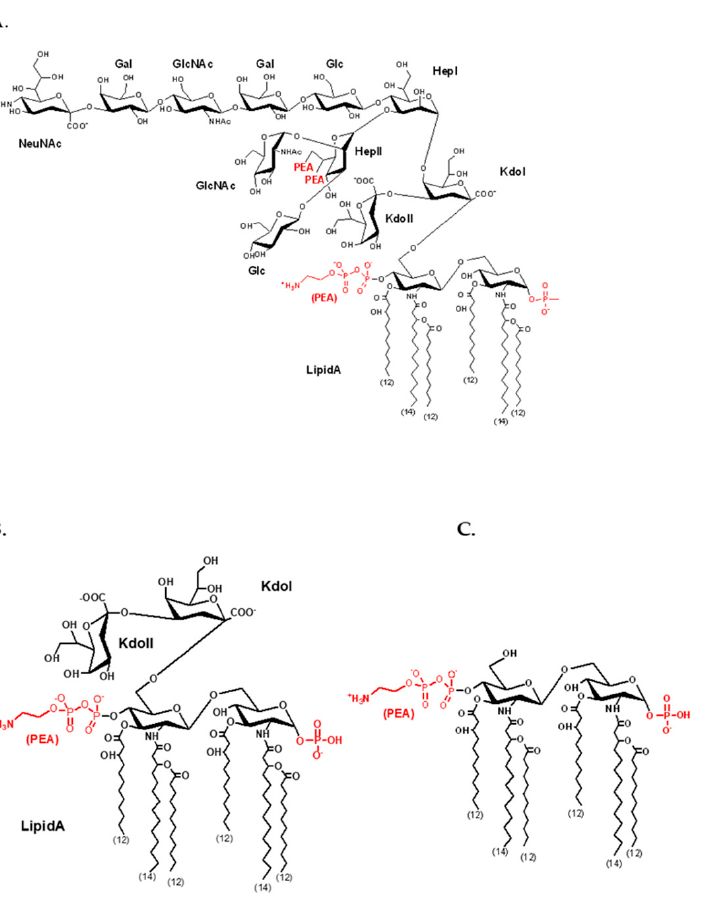
Figure A1. Schematic representation of meningococcal LPS structures. ( A ) N. meningitidis strain NMB wild-type LPS structure; ( B ) minimally glycosylated meningococcal KDO 2 -lipid A structure; ( C ) unglycosylated meningococcal lipid A structure.